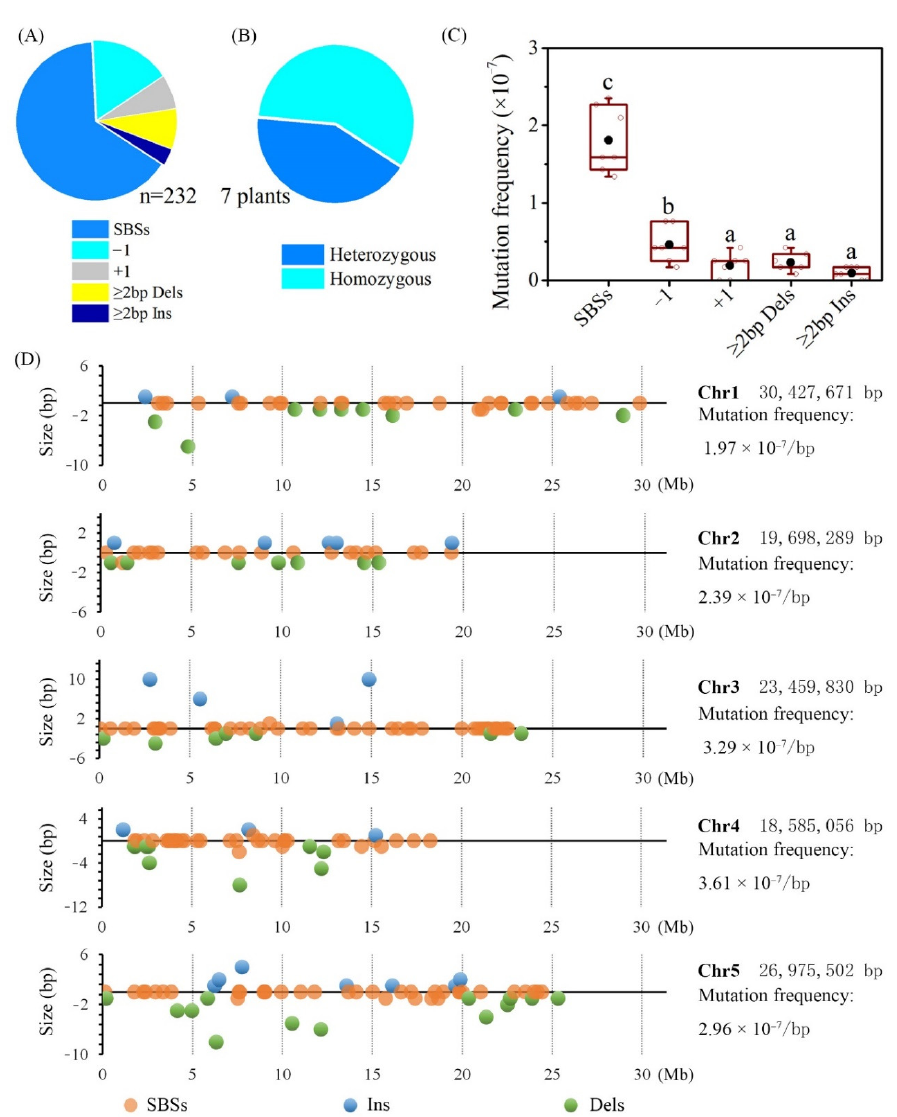
Figure 3. Summary of identified DNA sequence mutations. ( A ), Mutation type; ( B ), zygosity of mutations; ( C ) mutation frequency in M 3 genome, data followed by the same alphabetic letters are not significantly different between any two of the mutation types ( p > 0.05) by Duncan’s multiple range test; ( D ), the distribution of mutations on